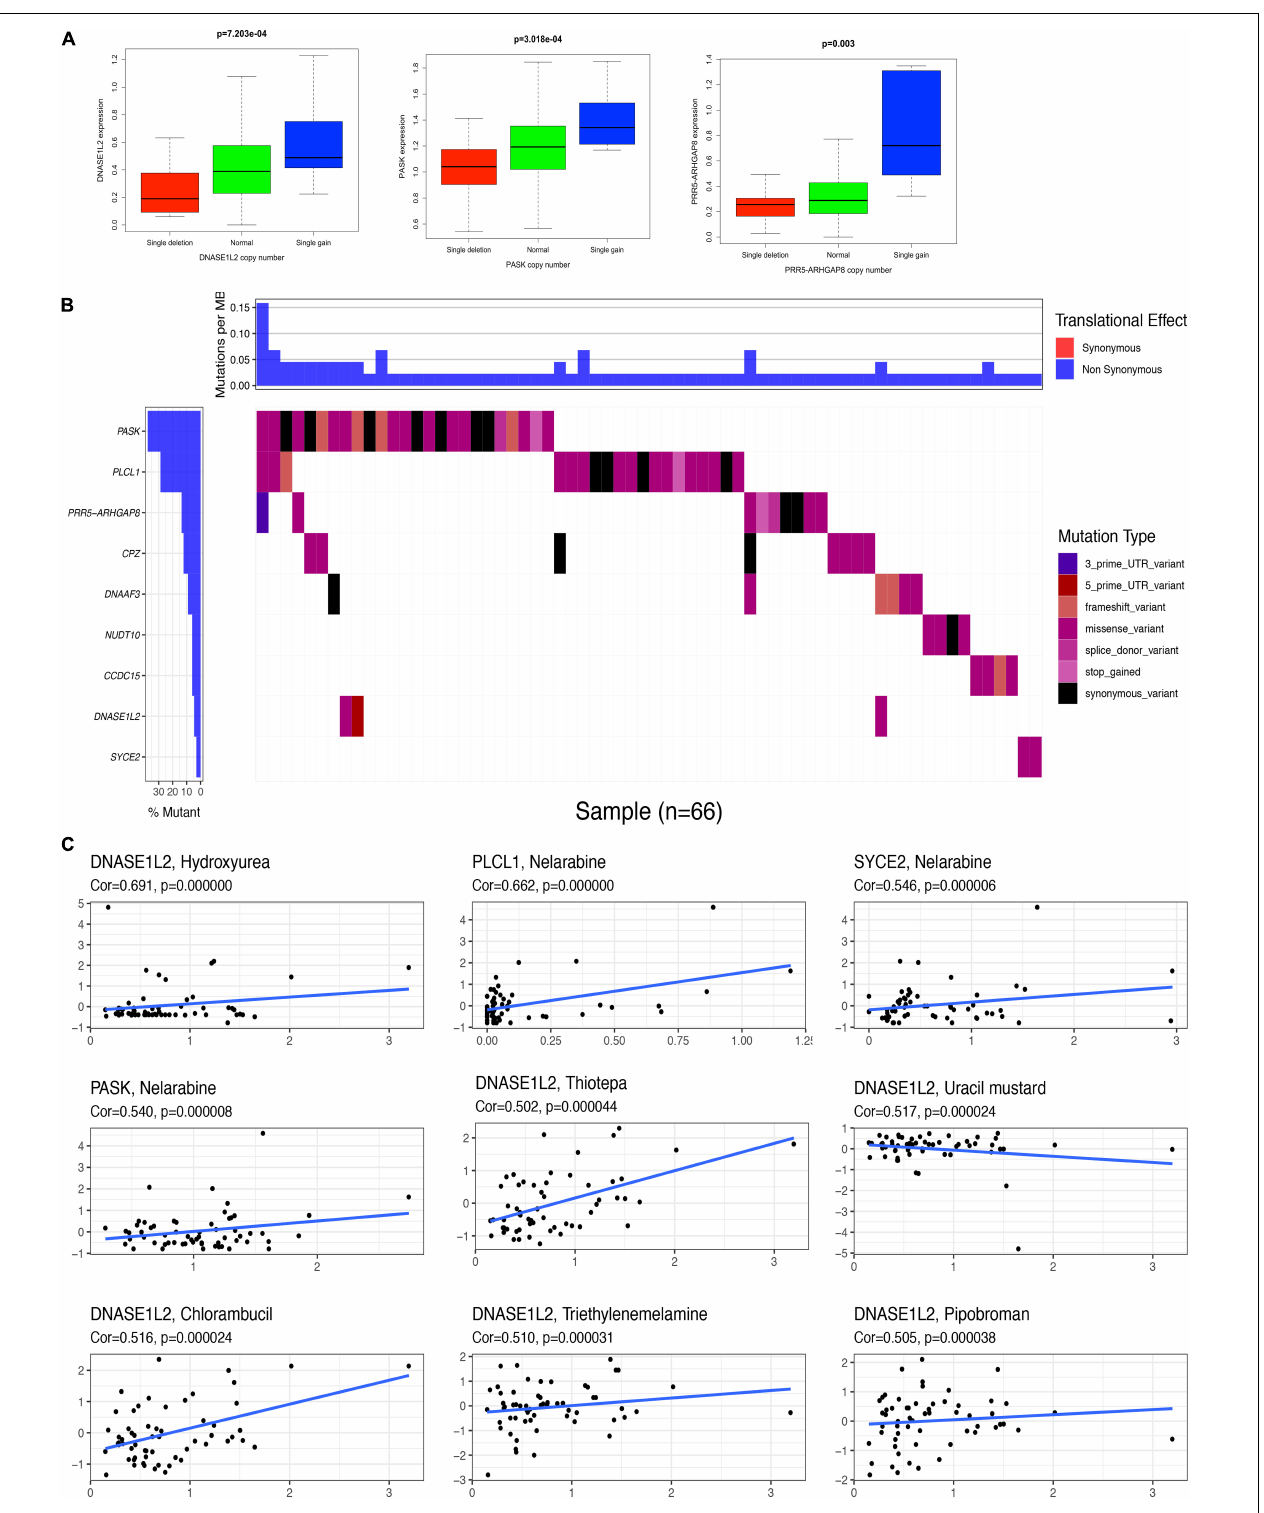
FIGURE 5 | Correlation analysis between the expression of genes in prognostic signatures and CNV, mutation, and drug sensitivity. (A) Correlation analysis between the expression of genes (DNASE1L2, PASK, and PRR5-ARHGAP8) in prognostic signatures and CNV. (B) The mutation distribution of genes (ARHGEF38-IT1, CCDC15, CPZ, DNASE1L2, NUDT10, PASK, PLCL1, PRR5-ARHGAP8, and SYCE2) in prognostic signatures. (C) Correlation analysis between the expression of genes (DNASE1L2, PLCL1, SYCE2, and PASK) in prognostic signatures and drug sensitivity.